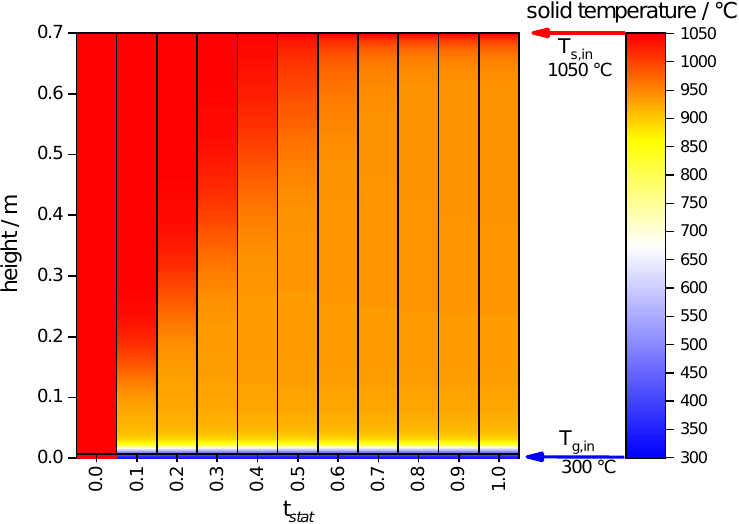
Figure 4. Heat map for the solid temperature development along the bed height of 0.7m of a moving bed with Mn-Fe-oxide particles moving with 4g/s in counter-current to 183L/min air flow ˙ V n . The time steps are normalized to the time t stat when a stationary temperature profile occurs after 400min for the current particle and gas flow